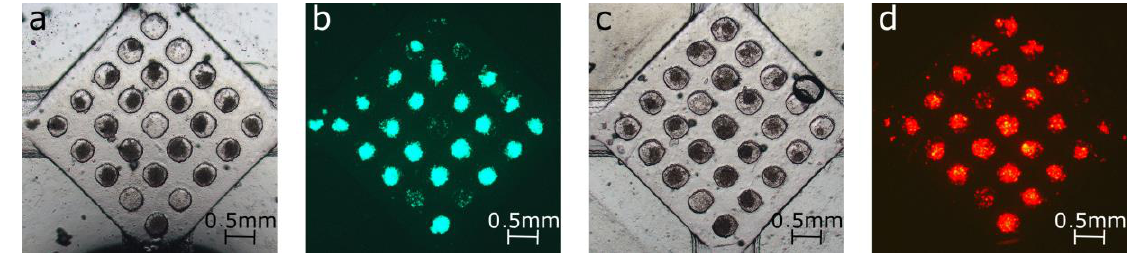
Figure 5. Cell culture in chamber array after 24 h incubation and after change of medium: OV1946 seeded at 2.5 × 10 6 cells/mL in ( a ) bright field and ( b ) fluorescence; OV90 seeded at 5 × 10 6 cells/mL in ( c ) bright field and ( d ) fluorescence.